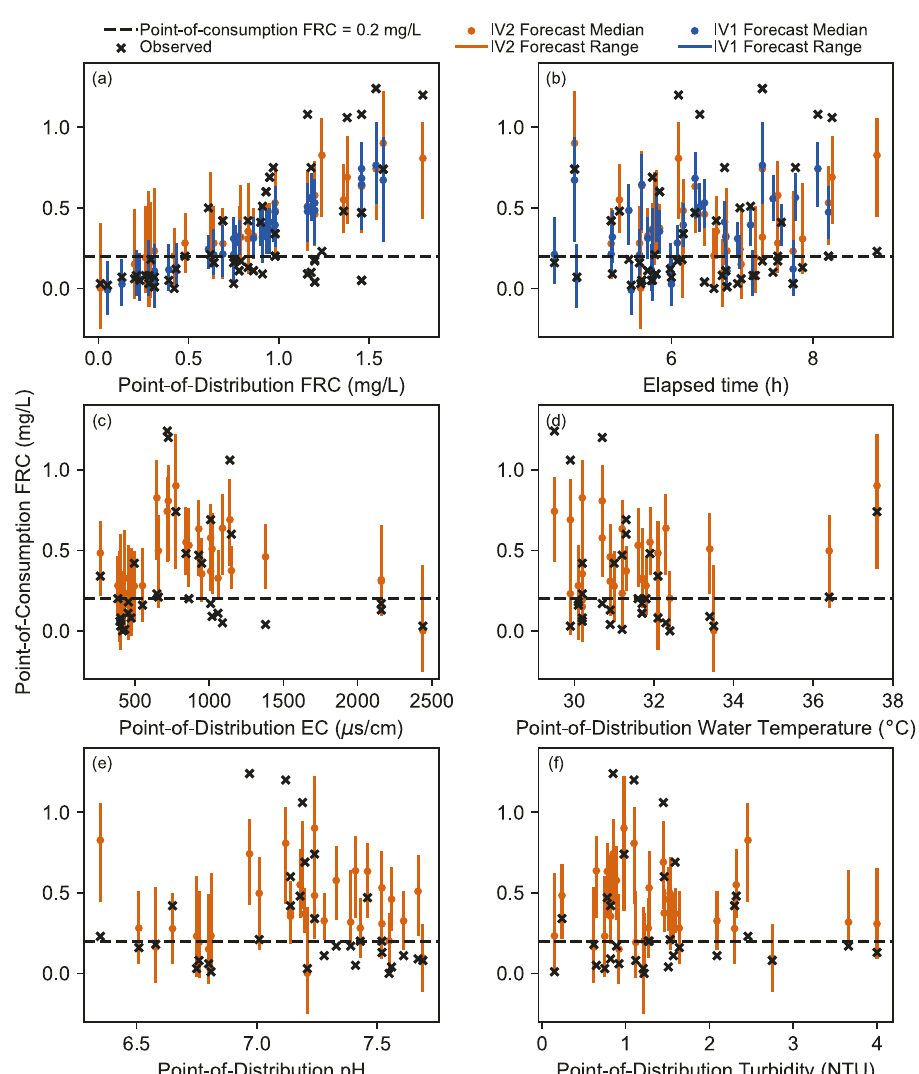
Fig. 3 South Sudan observations and post-processed forecasts of point-of-consumption FRC. The observations and forecasts are shown against a point-of-distribution FRC, b elapsed time, c point-of-distribution EC, d point-of-distribution water temperature, e point-of- distribution pH, f point-of-distribution turbidity. A strong trend between point-of-consumption and point-of-distribution FRC is observed and IV2 forecasts are much more dispersed than IV1